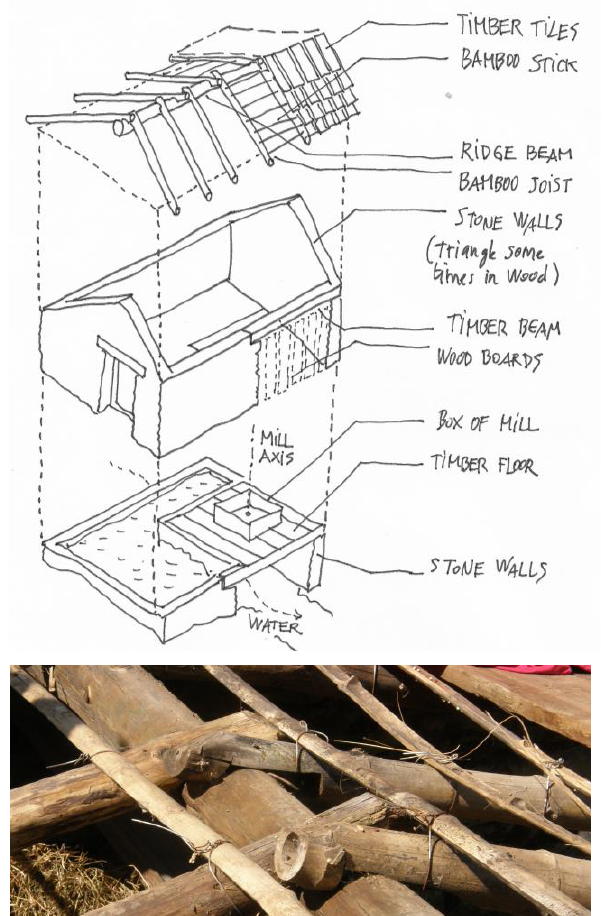
Figure 12. Constructive elements and ridge beam